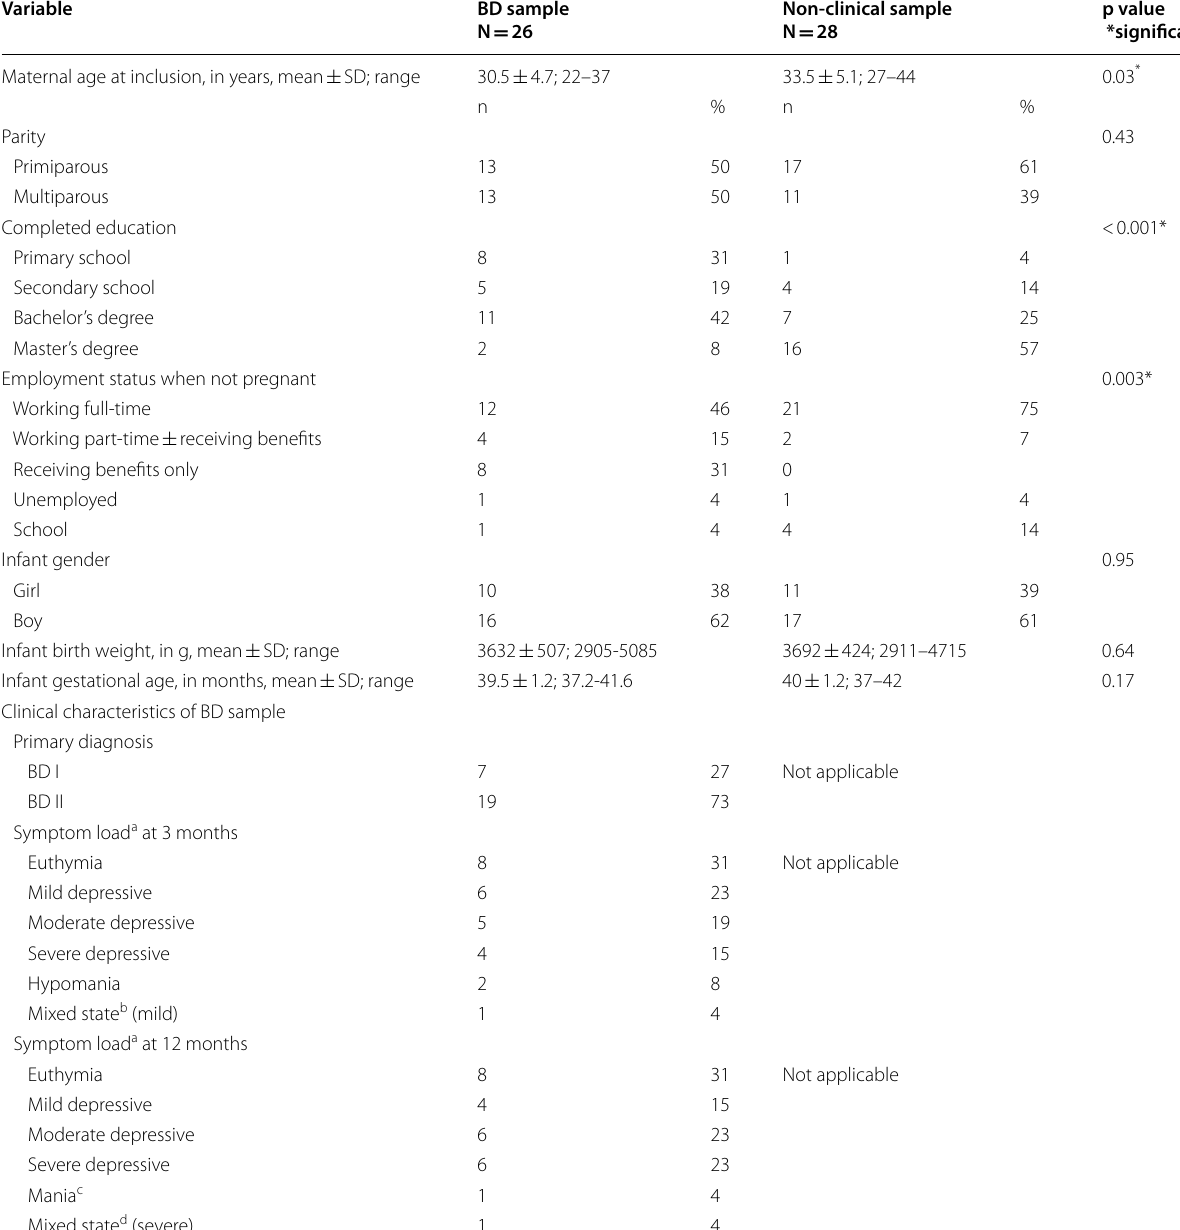
Table 1 Characteristics of mothers and infants in the BD and the non-clinical